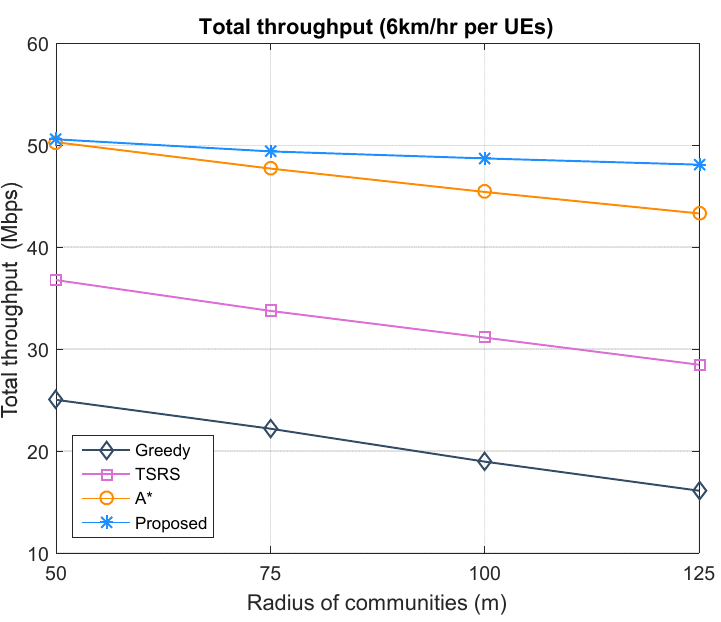
Figure 12. Throughput vs. group radius.